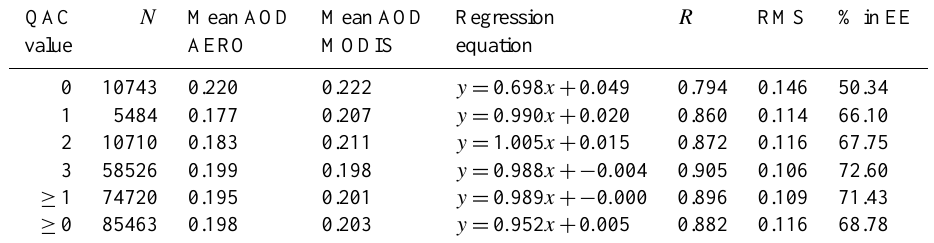
Table 2. Statistics of the comparison between MODIS and AERONET total AOD at 0.55µm over land, as a function of QAC.